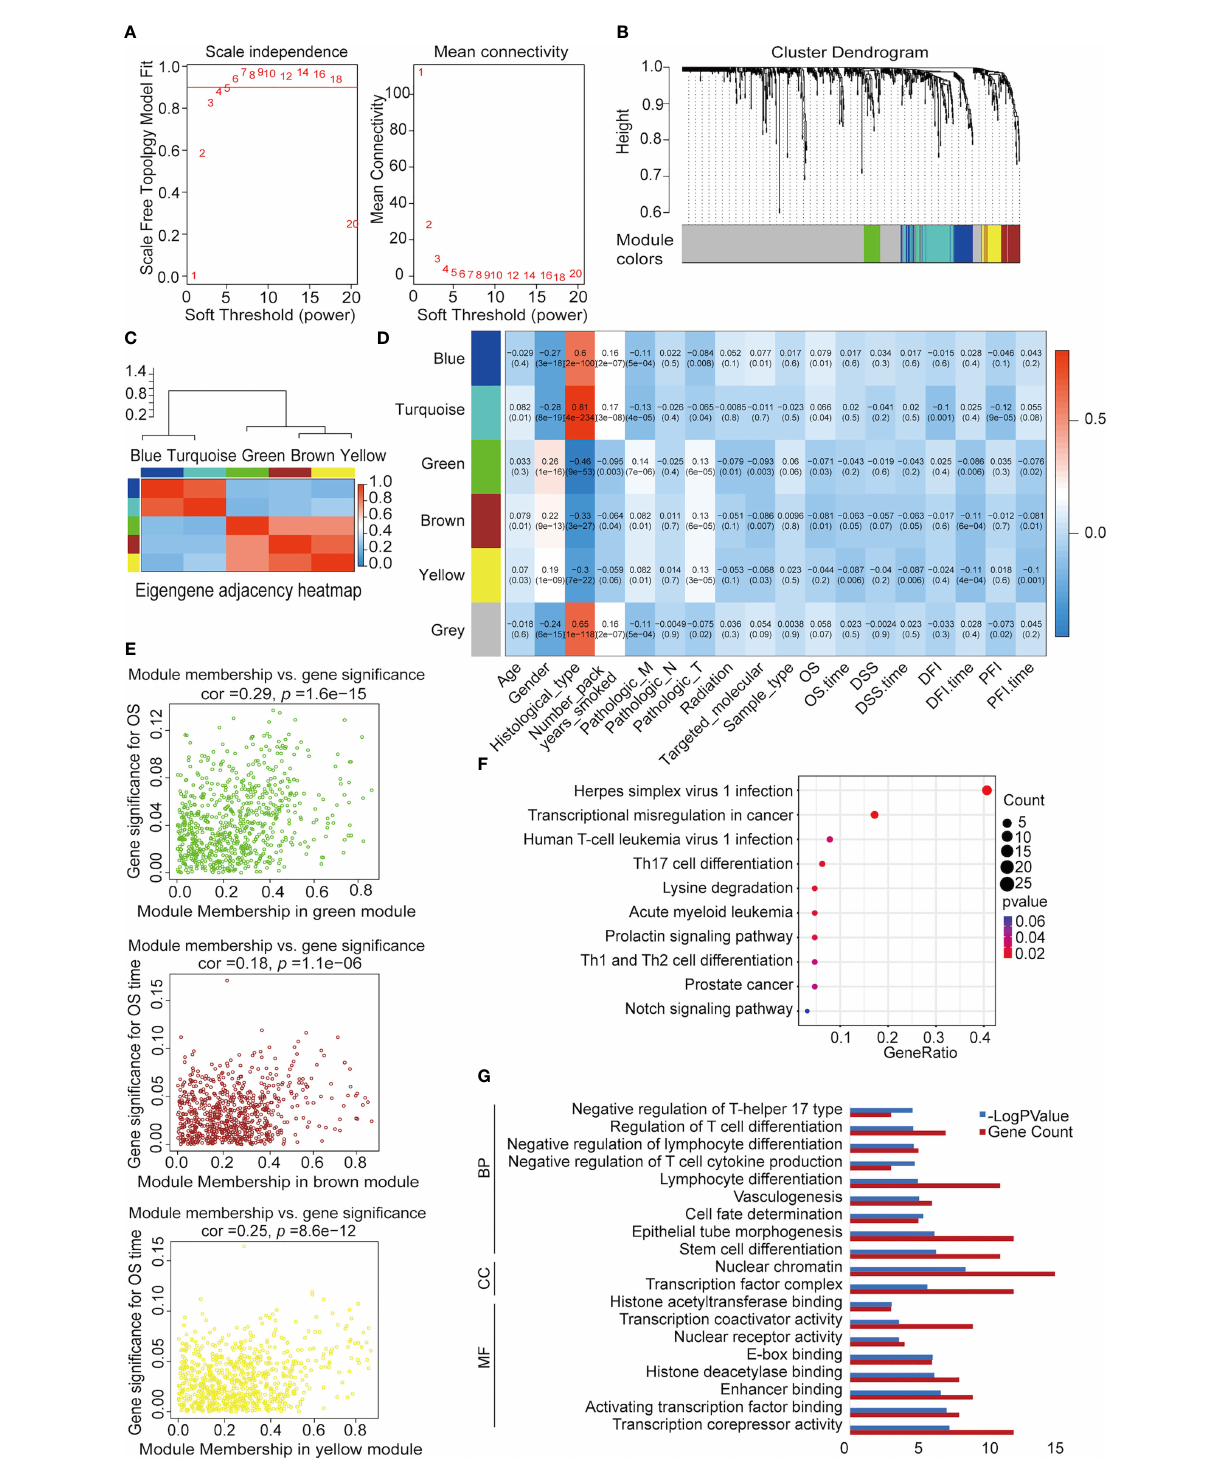
FIGURE 3 Construction of NSCLC co-expression module via WGCNA. (A) Analysis of network topology for various soft-threshold powers. Left: The relationship between the soft threshold b and the scale-free network topology R 2 , where the threshold is set to 0.9 for R 2 and the b value standard is the corresponding b value when R 2 reaches 0.9 for the fi rst time. Right: Relationship between the soft threshold b and connectivity. (B) Clustering dendrograms of TFs with dissimilarity based on topological overlap with assigned module colors. (C) Heatmap visualization of correlations between modules. (D) Analysis of module-NSCLC clinical data relationships. (E) Co-expression analysis of gene, brown, and yellow signi fi cance (GS) and module membership (MM). (F) Kyoto Encyclopedia of Genes and Genomes (KEGG) pathway enrichment of 118 TFs. (G) Functional annotation of 118 TFs using Gene Ontology (GO) term. MF, molecular function; CC, cellular component; BP: biological